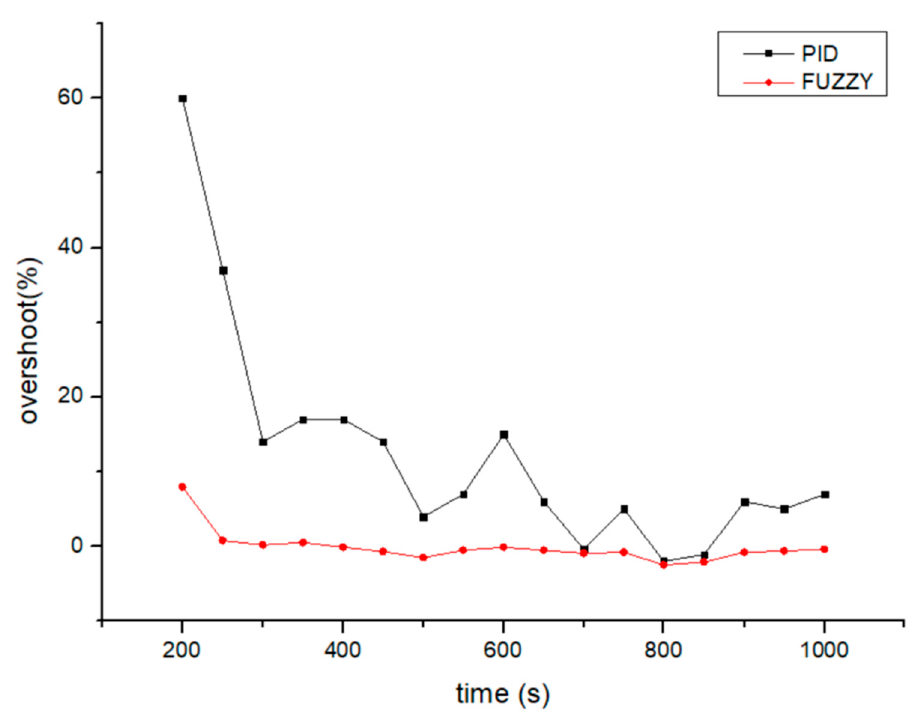
Figure 16. Comparison of the overshoots of traditional PID control and fuzzy control.